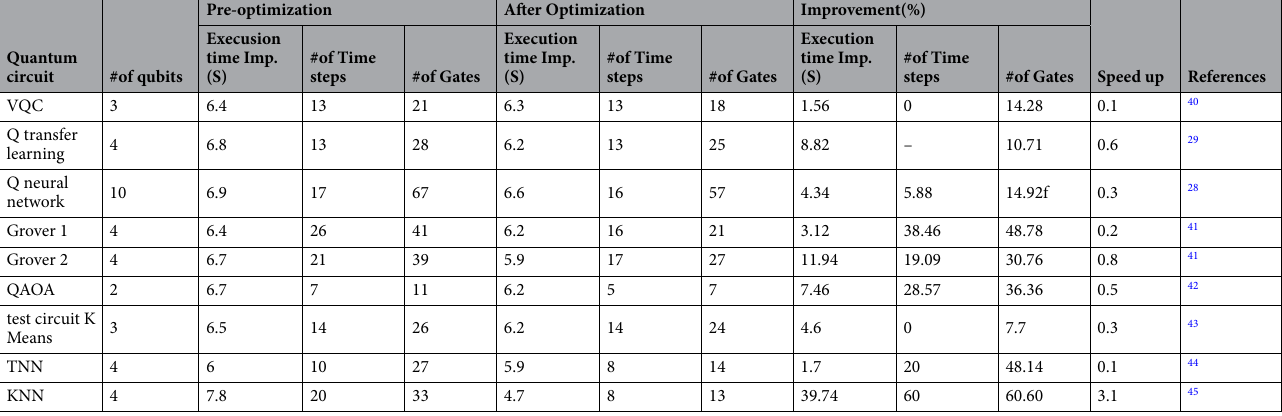
Table 1. Results of implementation of the proposed method on different quantum